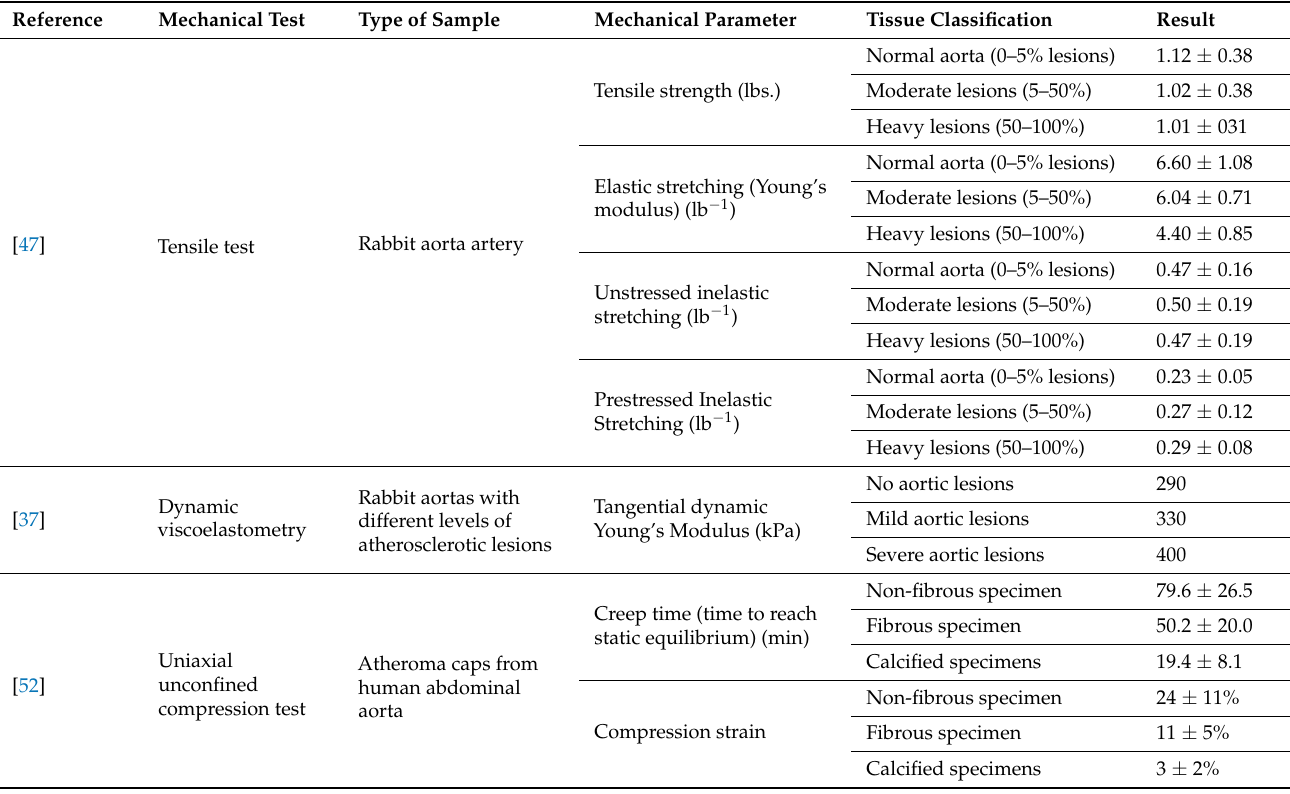
Table 4. Results of the studies reporting mechanical characterization of atherosclerotic